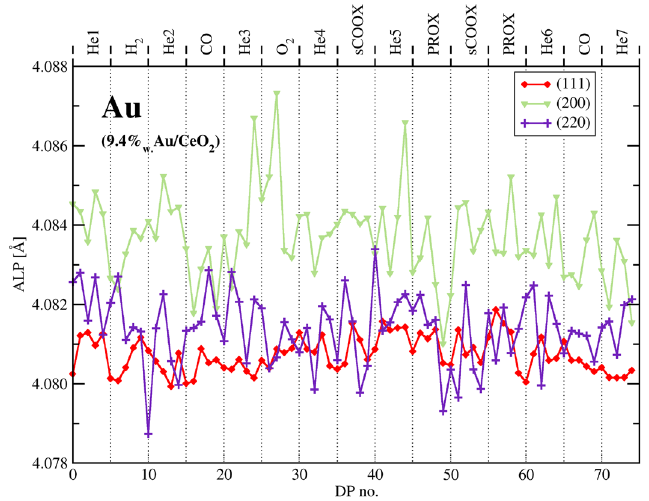
Figure 9. Apparent lattice parameter of gold of Au/CeO 2 during the experimental sequence recalculated to the constant